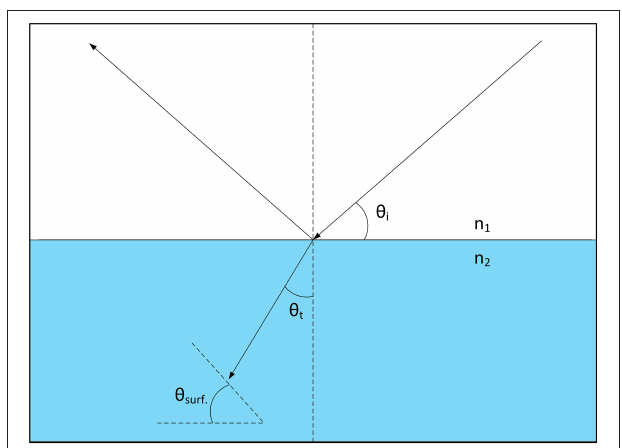
FIGURE 5 | Illustration of angles above and below the surface as a result of reflection and